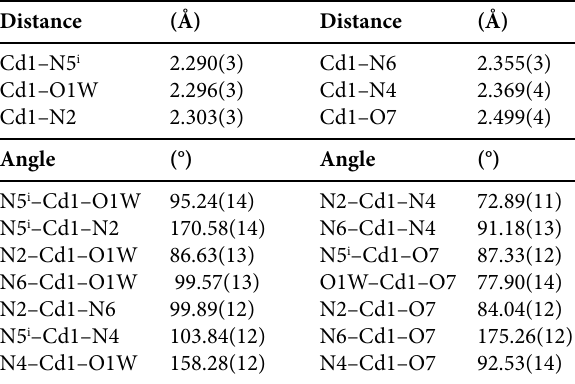
Table 2. Selected bond lengths (Å) and bond angles (º) for complex